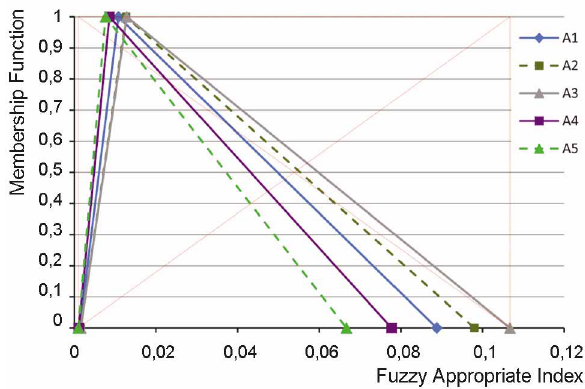
Fig. 4. Aggregated fuzzy appropriate index (FAI) of each alternative